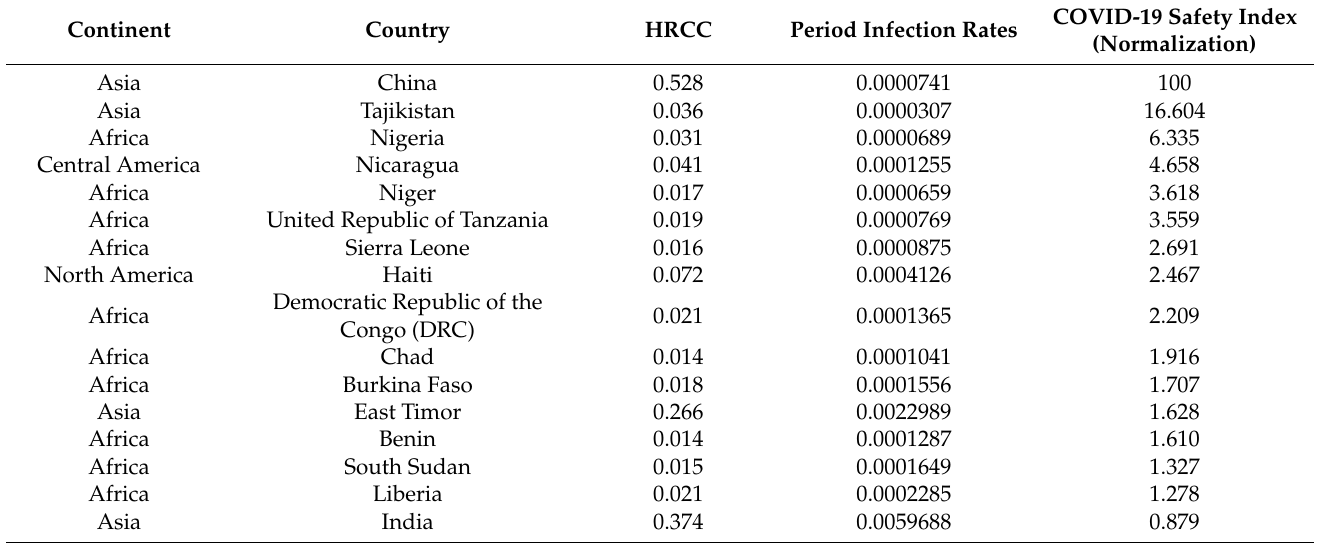
Table 7. Top 15 countries in the COVID-19 safety